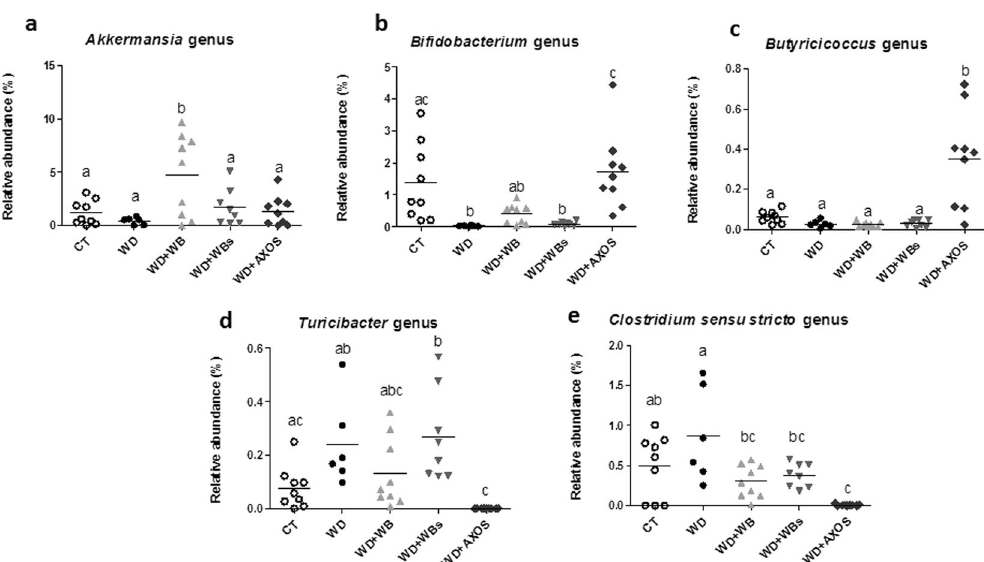
Figure 3. Impact of the three cereal fractions on the gut microbiota composition assessed by Illumina sequencing. Relative abundance of selected genera in cecal content of mice fed a control diet (CT), a western diet (WD), a WD supplemented with 5% of wheat bran fraction with large particles (WD + WB), a WD supplemented with 5% of wheat bran with reduced particle size (WD + WBs) or a WD supplemented with 5% of AXOS (WD + AXOS) for 8 weeks. Individual values are presented with mean. Data with different superscript letters are significantly different at p < 0.05